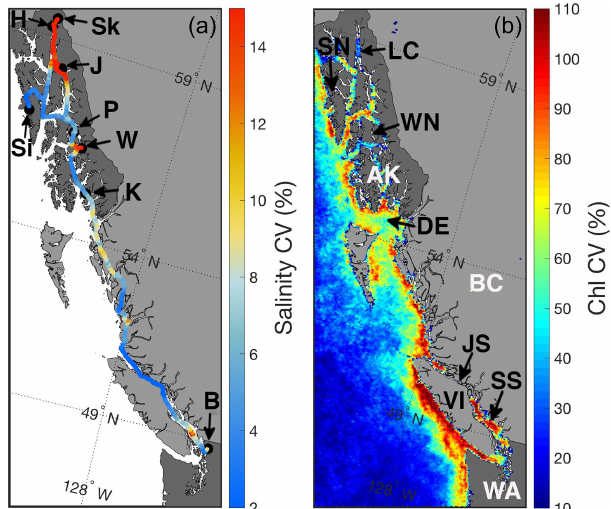
Figure 1. Surface salinity along the Inside Passage expressed as the coefficient of variation (CV; %; a ) computed for 0 . 03 ◦ × 0 . 03 ◦ monthly grid cells from underway measurements made from the M/V Columbia between 3 November 2017 and 2 October 2019. Areas of the highest salinity CV are due to large freshwater input, and black circles with labels mark the Alaska Marine Highway Sys- tem terminals: Bellingham, WA (B); Ketchikan, AK (K); Wrangell, AK (W); Petersburg, AK (P); Juneau, AK (J); Haines, AK (H); Sk- agway, AK (Sk); and Sitka, AK (Si). Also shown is the surface chlorophyll CV (%; b ) from Moderate Resolution Imaging Spec- troradiometer (MODIS) Level 3, 4km mapped data from February to October 2018 and 2019. Areas of high chlorophyll CV reflect in- stances of biomass accumulation presumably owing to periods of high primary productivity. Areas labeled in the figure panel are the states of Washington (WA) and Alaska (AK), the province of British Columbia (BC), Lynn Canal (LC), Sergius Narrows (SN), Wrangell Narrows (WN), Dixon Entrance (DE), Johnstone Strait (JS), Van- couver Island (VI), and the Salish Sea